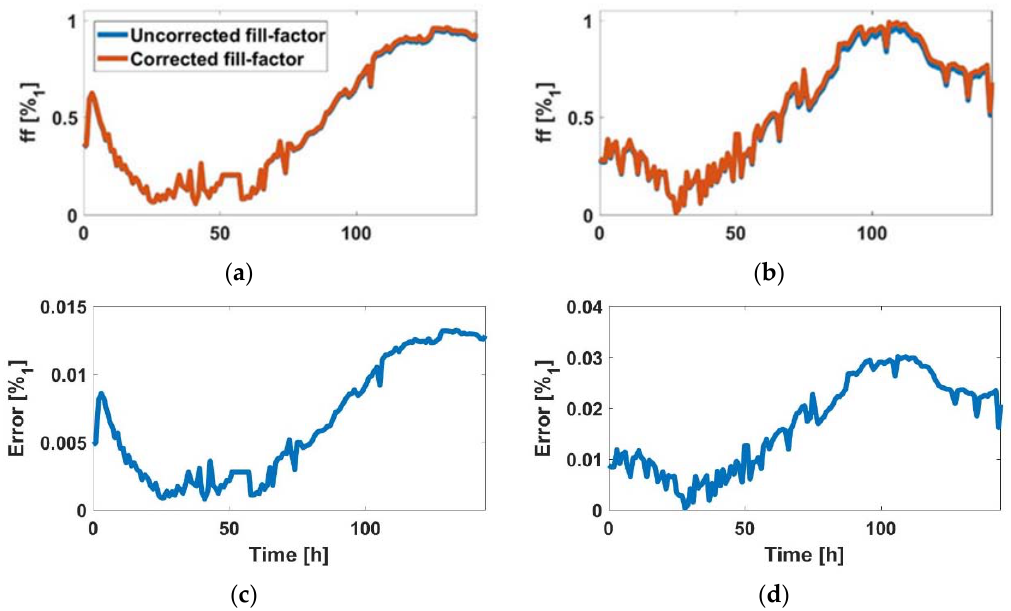
Figure 7. ( a ) Comparison between uncorrected and corrected ff . ( b ) ff estimation error (N2aAPP with 2500 cells at the beginning). ( c ) Comparison between uncorrected and corrected ff , and ( d ) ff estimation error (N2aAPP with 5000 cells at the beginning).